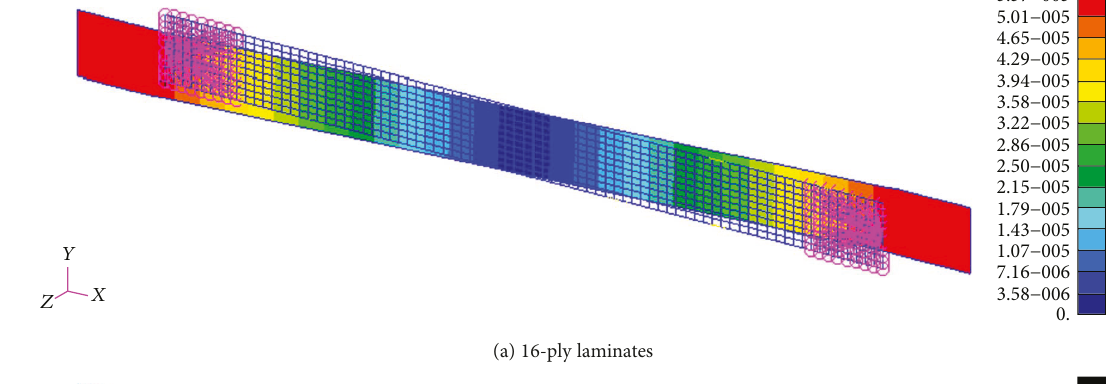
Table 5: Simulation results of hybrid A